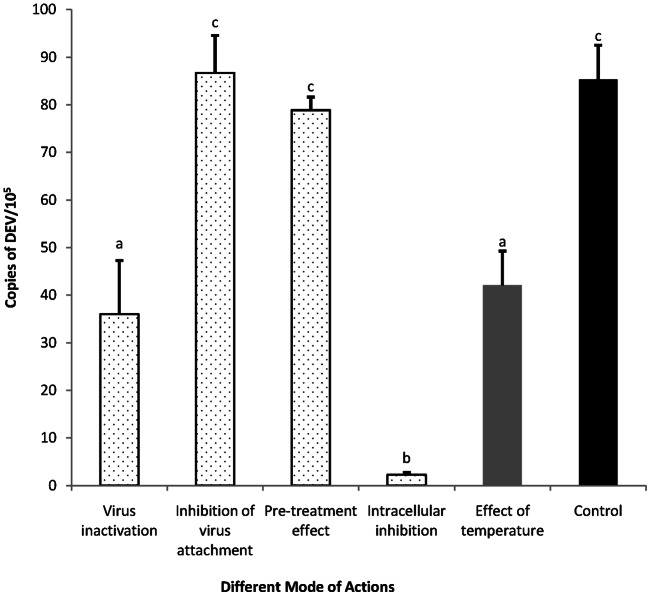
Influence of different treatment conditions of resveratrol on DEV infection.DEFs infected with DEV (MOI  = 0.1) were treated with resveratrol in various mode of actions. (1) Virus inactivation: DEV was treated with drug for 1 h at 37°C before infection. The virus and drug mixture was then added to cells for 1 h at 37°C. The media was removed and replaced with drug-free media. DEV suspended without drug was used as control (effect of temperature). (2) Inhibition of virus attachment: DEFs were infected in media containing the drug and virus for 1 h at 37°C, and then the mixture was removed. The cells were overlaid with drug-free media. (3) Pre-treatment effect: DEFs were pre-treatment with drug for 1 h at 37°C. And then DEV was added to the cells after resveratrol solution removal. After 1 h 37°C, the inoculum was removed and replaced with drug-free media. (4) Intracellular inhibition: after removing the unabsorbed virus, the media containing the resveratrol was added to the DEFs. At 48 h p.i., the total DNA was extracted from DEV-infected DEFs and copies of DEV were evaluated by the real-time FQ-PCR assay. Values are means ± SD (n = 3). Significance: different capital letters represent extremely significant differences among groups (P<0.01, n = 3).